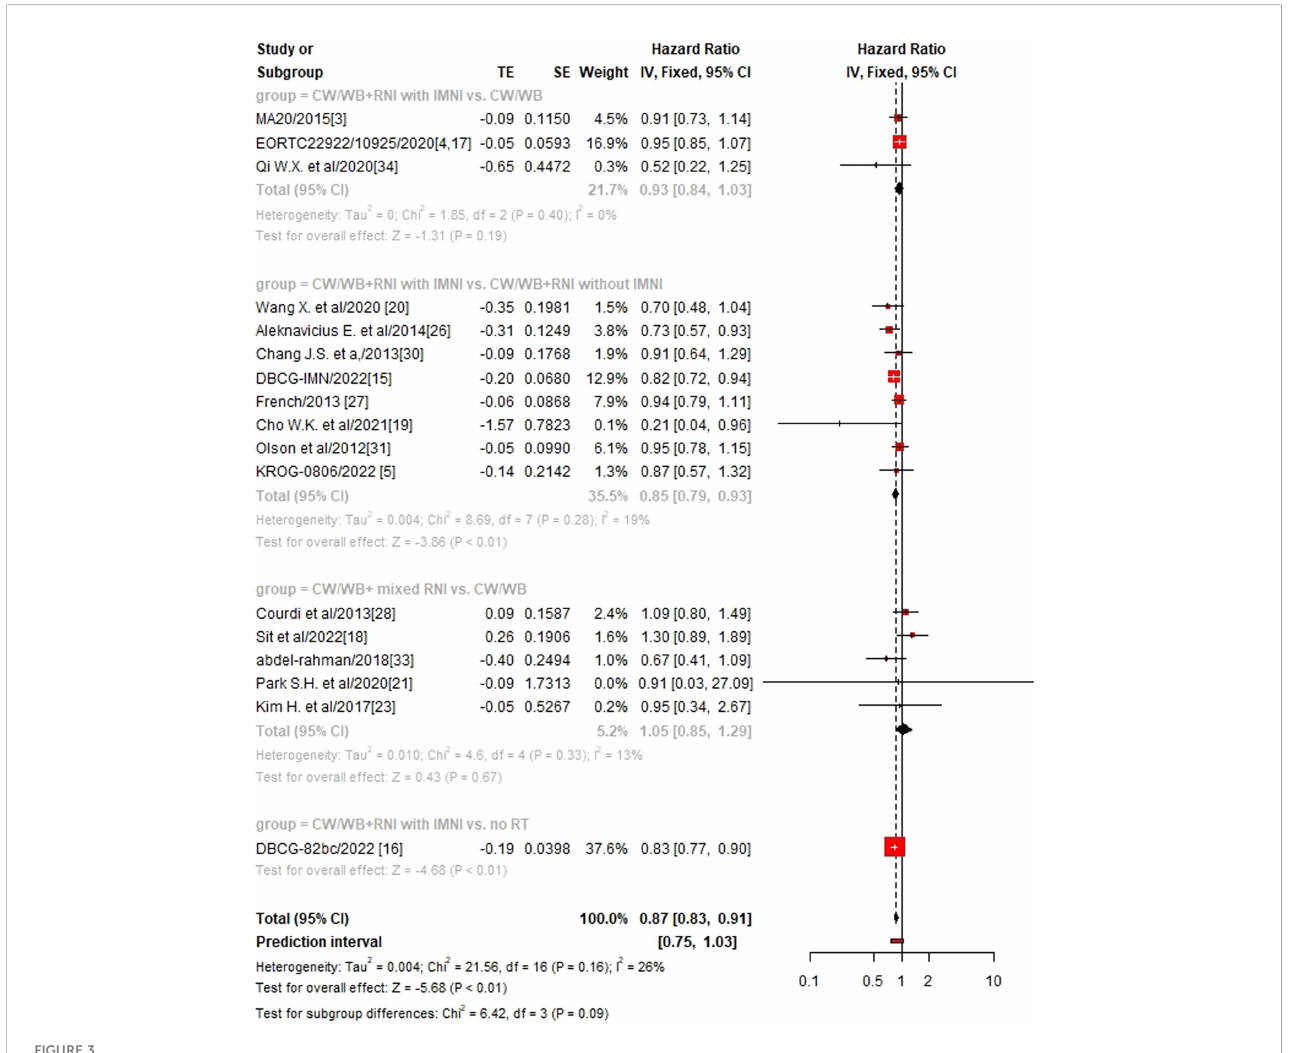
FIGURE 3 Sub-group analysis of OS according to RNI volume in early-stage